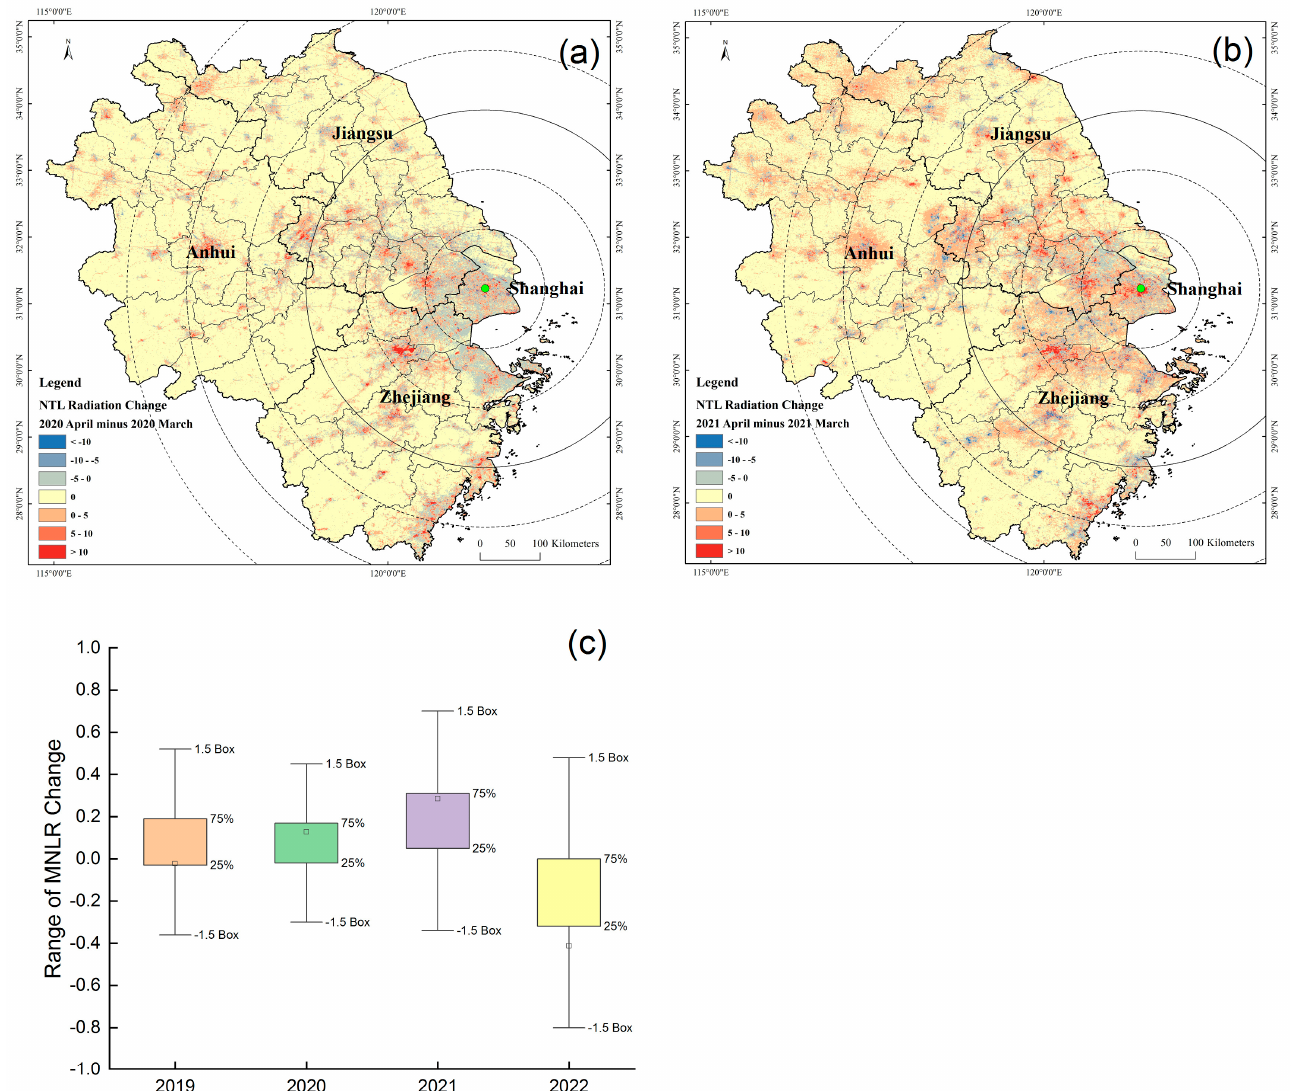
Figure 5. Comparison of spatio-temporal variation of MNLR from March to April before and after COVID-19: ( a ) from March to April 2019; ( b ) from March to April 2020; ( c ) from March to April 2021;